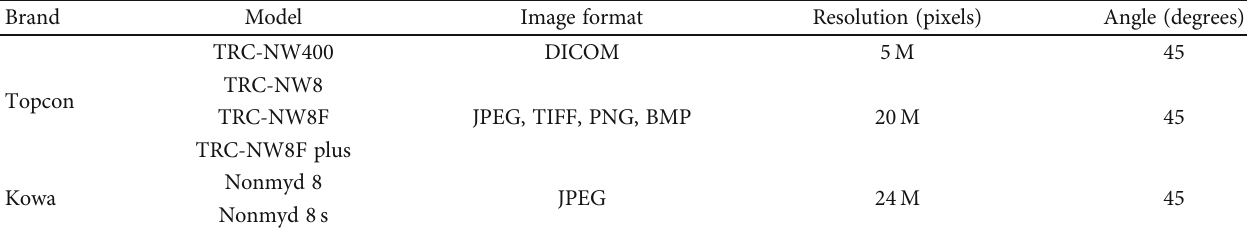
Table 1: Pro fi les of the color fundus cameras for validation with VeriSee DR.